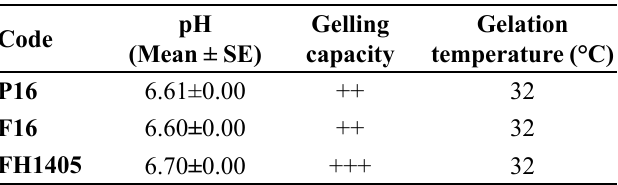
TABLE III - pH, gelling capacity and gelation temperature of in situ gelling (n=6) Code